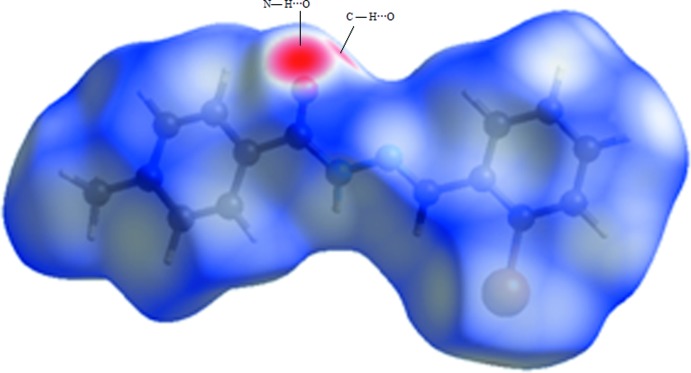
The three-dimensional dnorm surface of the title compound. add contouring levels